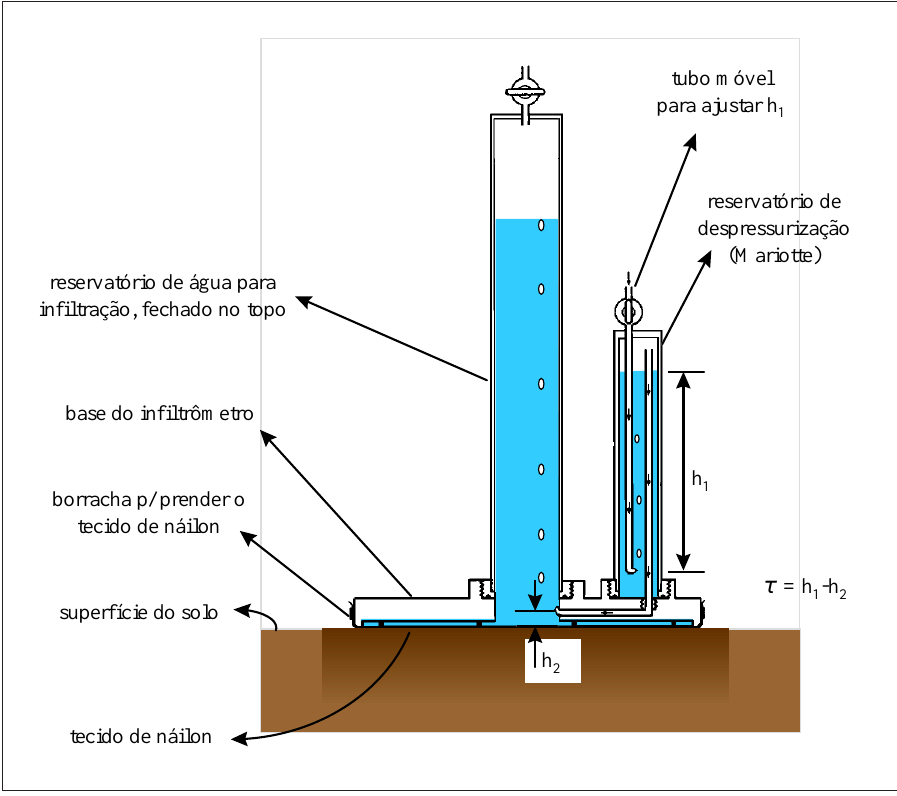
Figura 1. Esquema do infiltrômetro de tensão